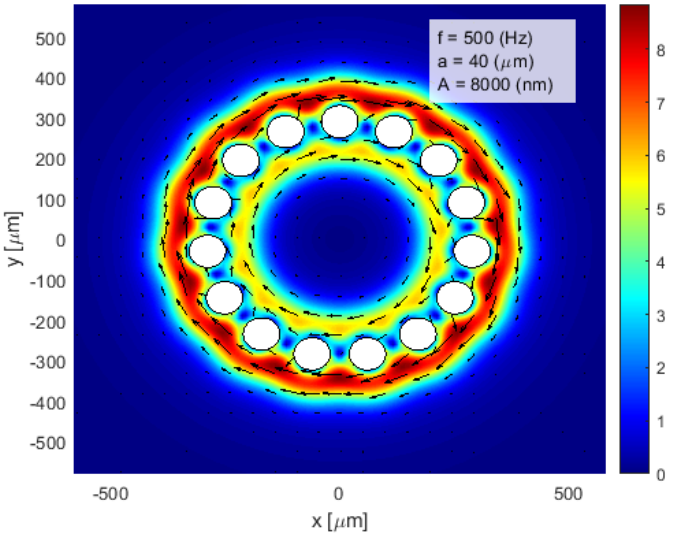
Figure 6. Rotational velocity of water stream 𝑣 𝑟 in an open pot-like layout. If the pillars overlapped physically, like in Figures 7–9, then the mathematical Equation (12) was modified so as not to take into account the water streaming caused by the parts of the pillars which are outside the pot, or part of the wall.